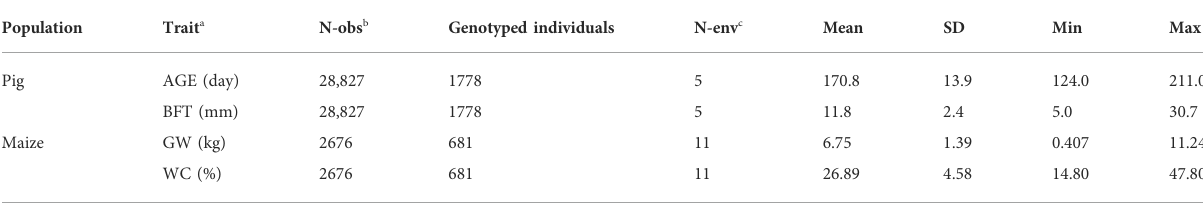
TABLE 1 Descriptive statistics for pig and maize population traits. Population Trait a